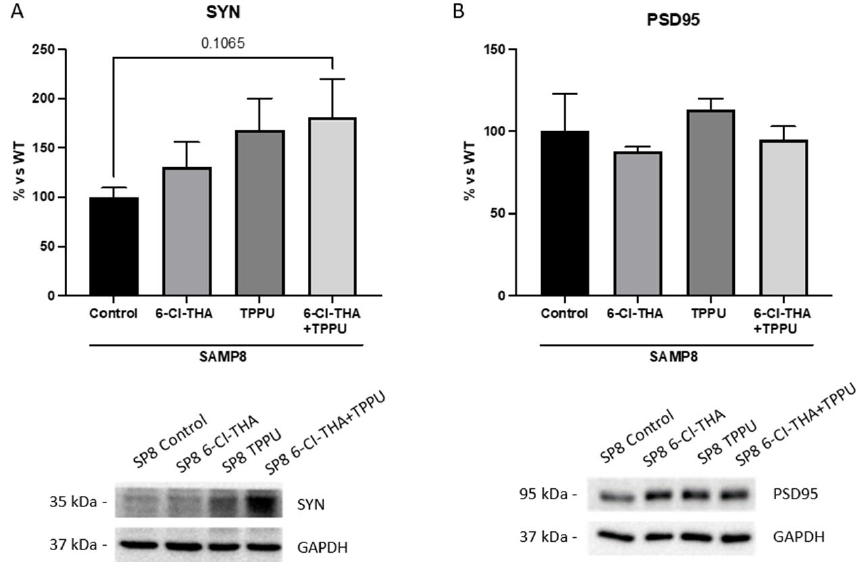
Figure 2. Neuronal synaptic markers in the SAMP8 hippocampus after treatments. Representative WB and quantification of ( A ) SYN and ( B ) PSD95. Results are expressed as a mean ± SEM. SAMP8 control, n = 3; SAMP8 treated with the TPPU (1 mg/kg/day), n = 3; SAMP8 treated with 6-Cl-THA (1 mg/kg/day), n = 3; SAMP8 subjected to co-treatment with TPPU (1 mg/kg/day) plus 6-Cl-THA (1 mg/kg/day), n = 3. Groups were compared by a one-way ANOVA test and post-hoc Tukey’s test. n = 4–6. Abbreviations: 6-Cl-THA = 6-chlorotacrine; SYN = synaptophysin; PSD95 = postsynaptic density protein; SP8 = SAMP8.